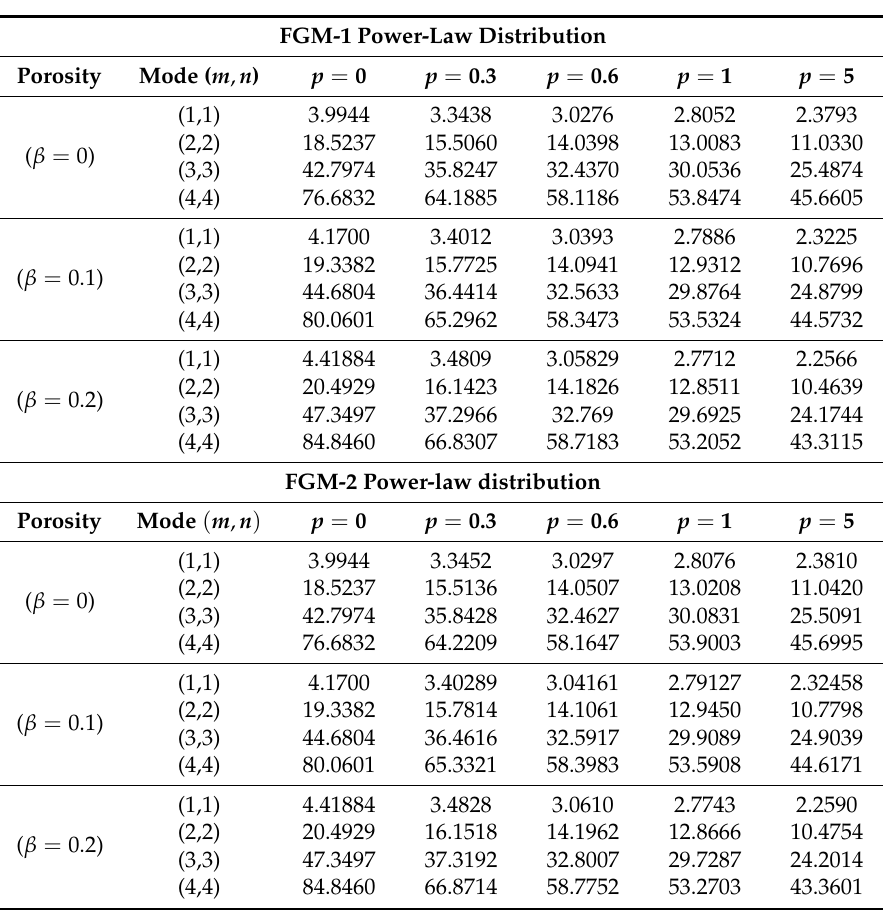
Table 4. Dimensionless frequency of simply-supported (SSSS) functionally graded porous hyperbolic paraboloidal shell as functions of the power-law index and porosity volume